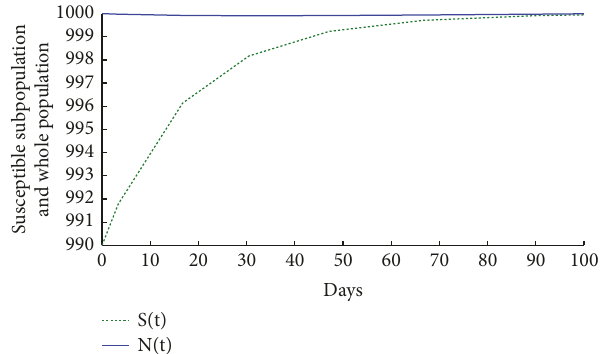
Figure 7: Normalized subpopulations of susceptible, infectious, and vaccinated in the SISV model with a vaccination strategy based on the control law (3).